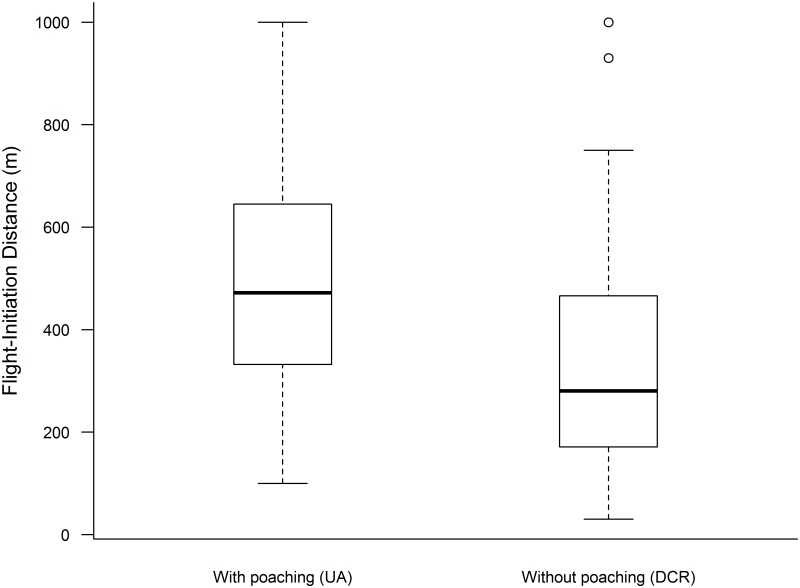
Boxplot of Flight-initiation distance (FID, in meters) in relation to the poaching situation.The horizontal bold line in the box indicates the median value of the data. The upper and lower 1 hinges of the box indicate the 75th and 25th percentiles of the data set, respectively. The ends of the vertical lines indicate the minimum and maximum data values, the points outside the ends of the whiskers are outliers.